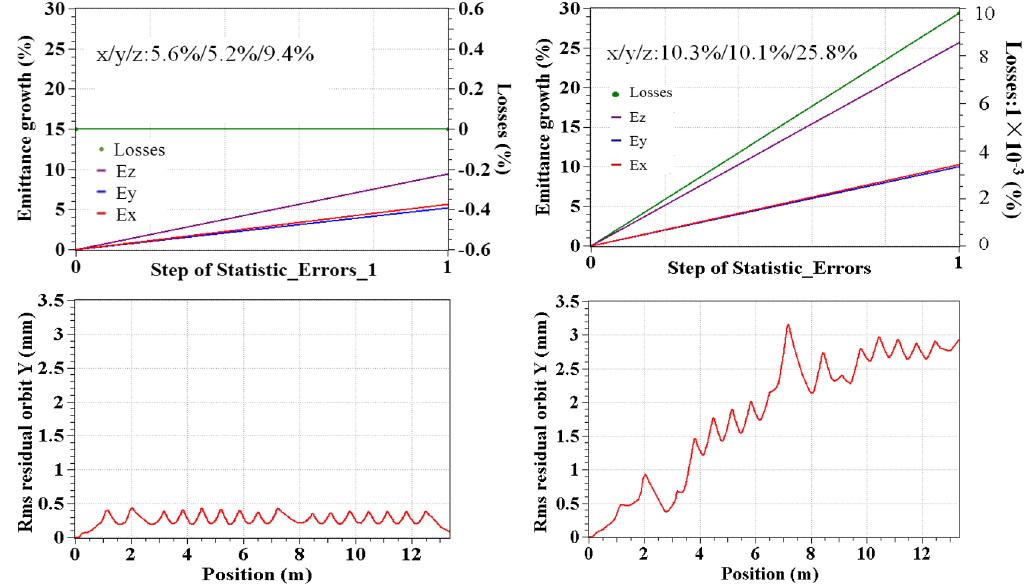
FIG. 20. The normalized RMS emittance growth and beam loss with errors and corrections (left graphs), with errors but no corrections (right